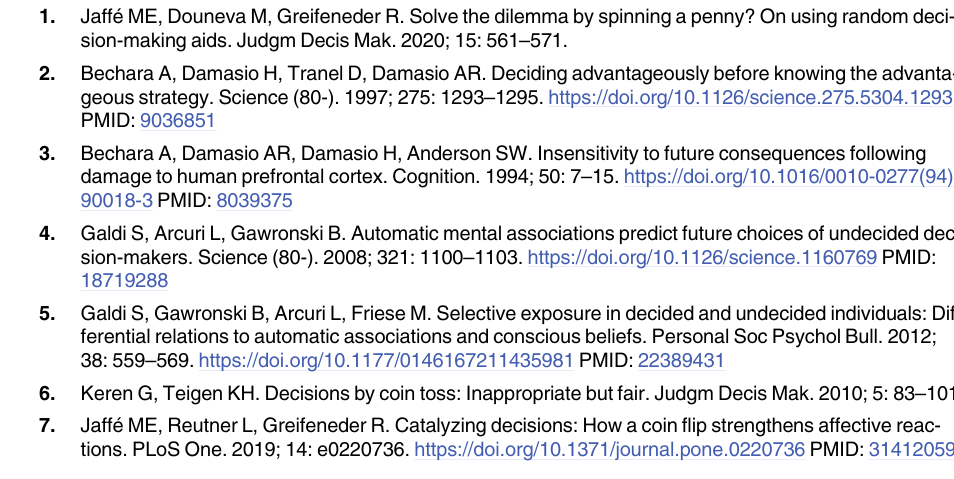
S1 Table. Descriptive results for certainty, faith in intuition, superstition, belief in fate, satisfaction, and difficulty across the studies presented in this